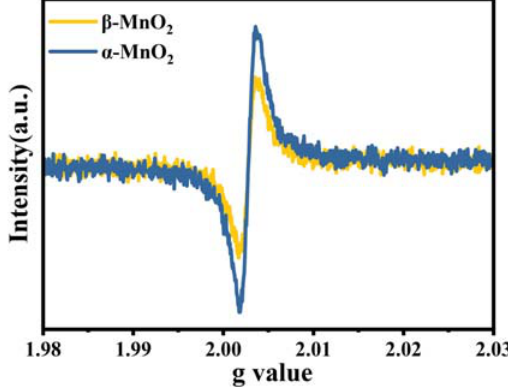
Figure 3. EPR profiles of α -MnO 2 and β -MnO 2 .